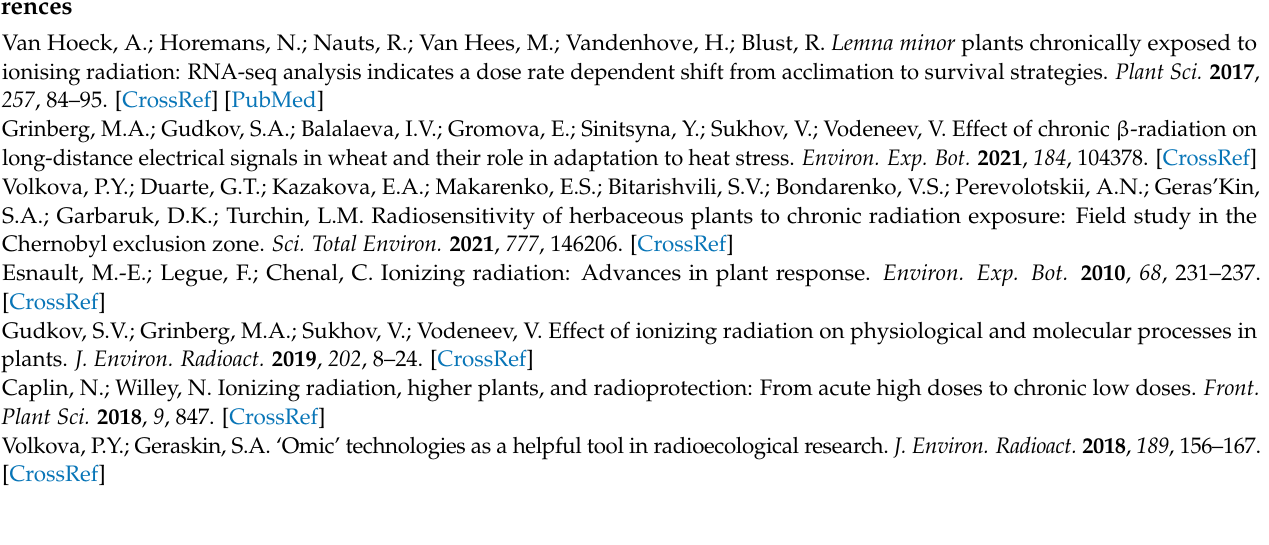
Table S2: Chlorophyll fluorescence parameters; Table S3: Differential gene expression for chronically irradiated A. thaliana seedlings; Table S4: Functional enrichment GO analysis for chronically irradiated A. thaliana seedlings; Table S5: Differential gene expression for additionally gamma-irradiated A. thaliana seedlings; Table S6: Functional enrichment GO analysis for additionally gamma-irradiated A. thaliana